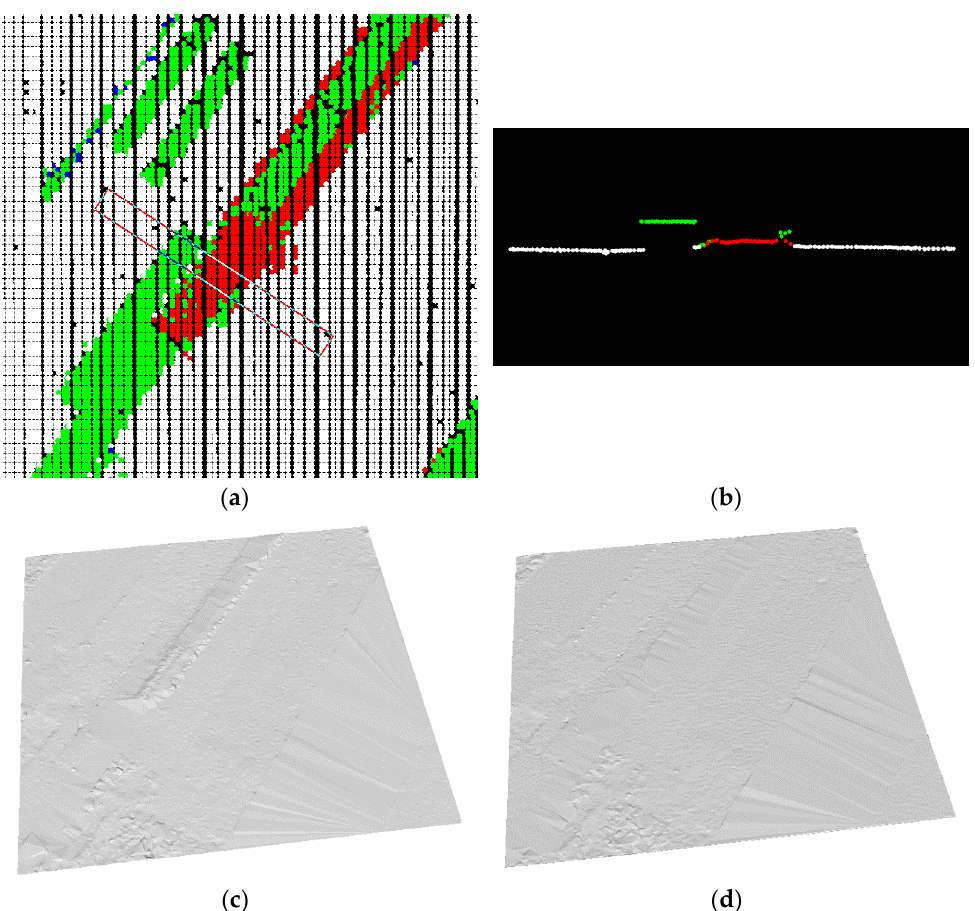
Figure 13. ( a ) Area that deep CNN model accept many wrong ground points, where the white points denote correctly classified ground points, the green points denote correctly classified non-ground points, the red points denote accepted non-ground points, and the blue points denote rejected ground points; ( b ) the profile of that area; ( c ) DTM of that area by deep CNN model; and ( d ) ground truth DTM of that area. The root mean square error (RMSE) between the DTM by deep CNN model with the ground truth DTM in this section shown below is 0.1 m.